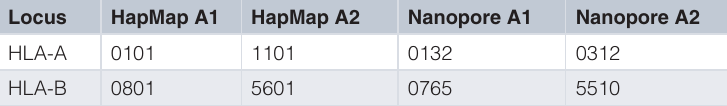
Table S3. HLA alleles called with 4-digit resolution using the GATK HLACaller.